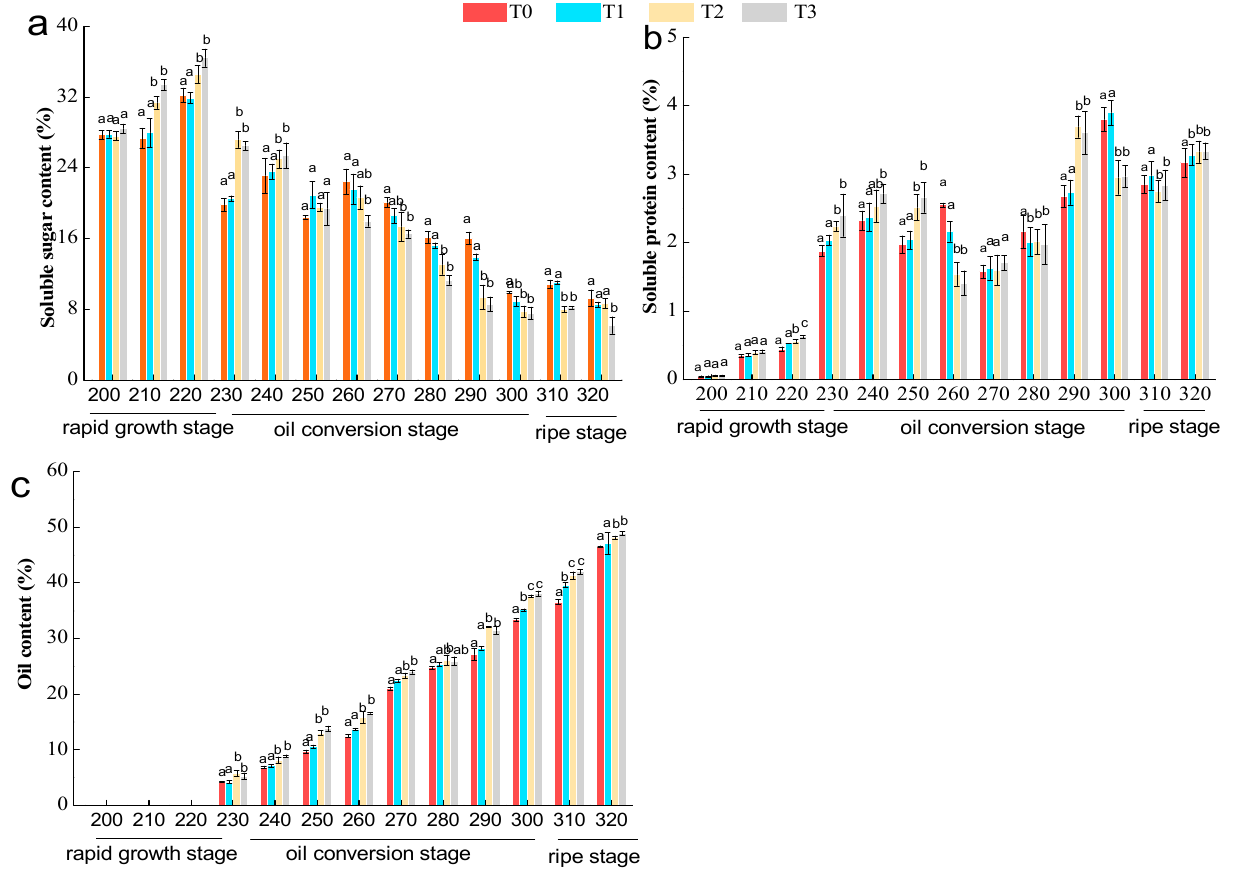
at 320 DAFB; T0, T1, and T2 increased the SSCSK by 33%, 27.3%, and 28.5%, respectively, compared with T3.